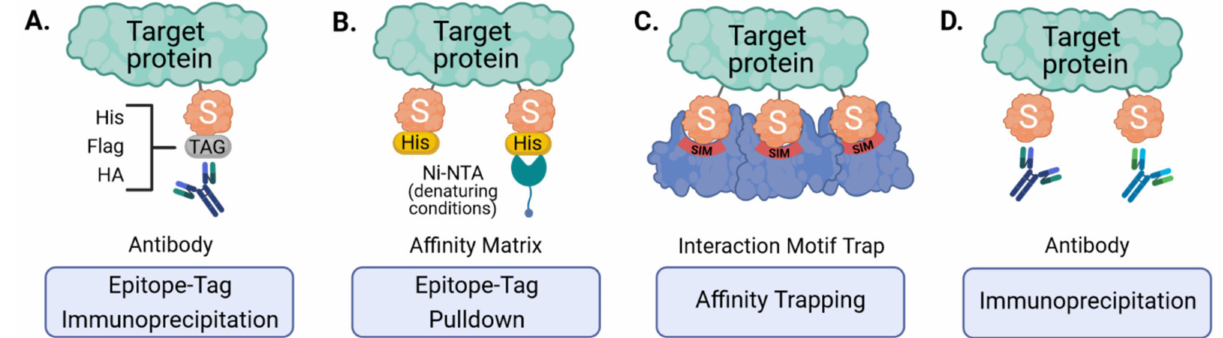
Figure 3. Strategies for the enrichment of SUMOylated target proteins. Ectopically expressed, epitope-tagged SUMO can be purified using tag-specific antibodies ( A ) or affinity matrices that bind specific tags (e.g., His6-tag and Ni-NTA under denaturing conditions) ( B ). Endogenous SUMO can also be enriched by engineered SUMO-traps that consist of multiple SUMO-interacting motifs (SIMs) immobilized onto an affinity matrix ( C ) or by immunoaffinity purification using SUMO-specific antibodies ( D